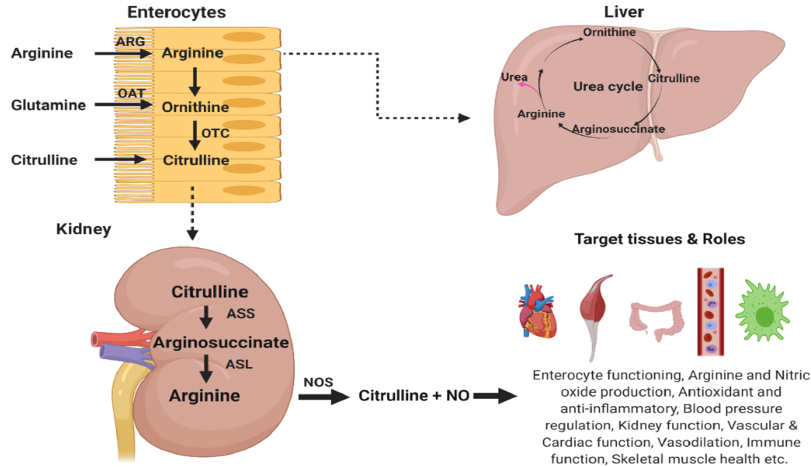
Figure 3. Overview of citrulline metabolism and related amino acids. ARG, arginase; OAT, ornithine aminotransferase; OCT, ornithine carbamoyltransferase; ASS, argininosuccinate synthetase; ASL, argininosuccinate lyase. Created with BioRender.com, accessed on 6 February 2021.